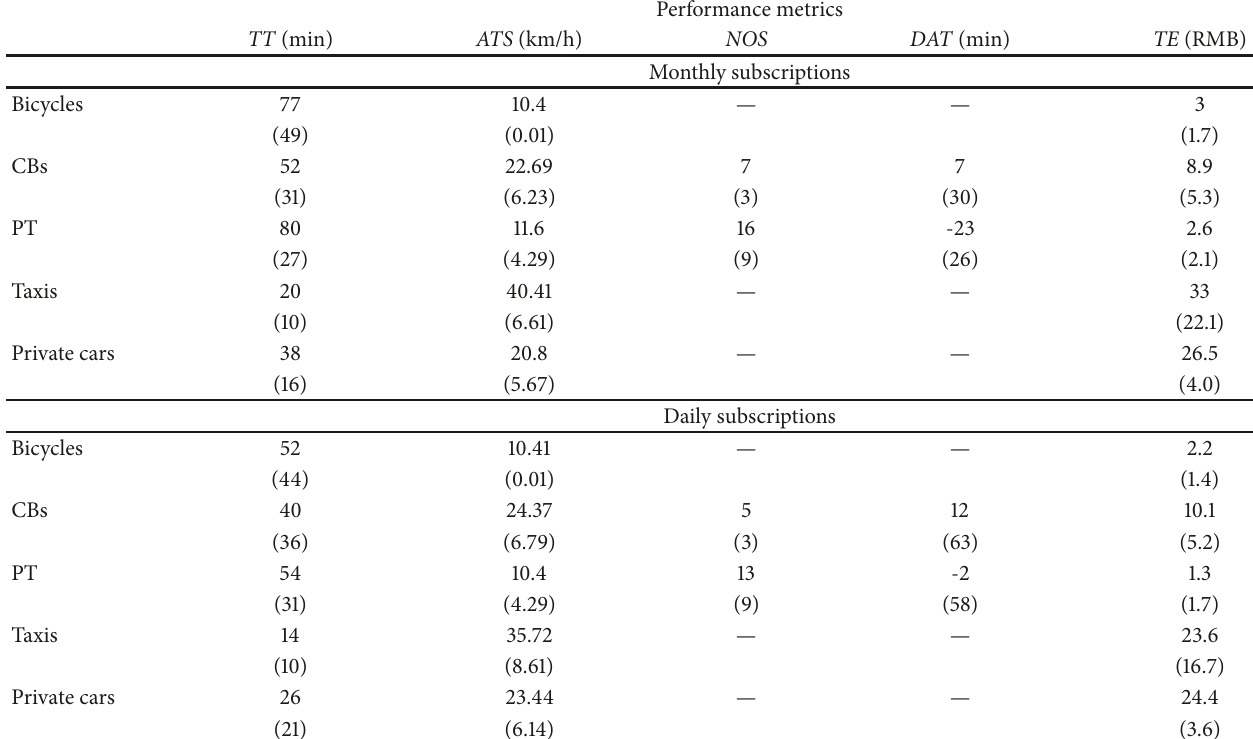
Table 2: Means of performance metrics for the five travel modes (standard deviation in